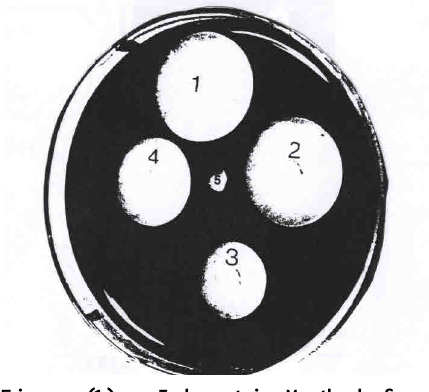
Figure (1): Iodometric Method for Detection of  -Lactamase